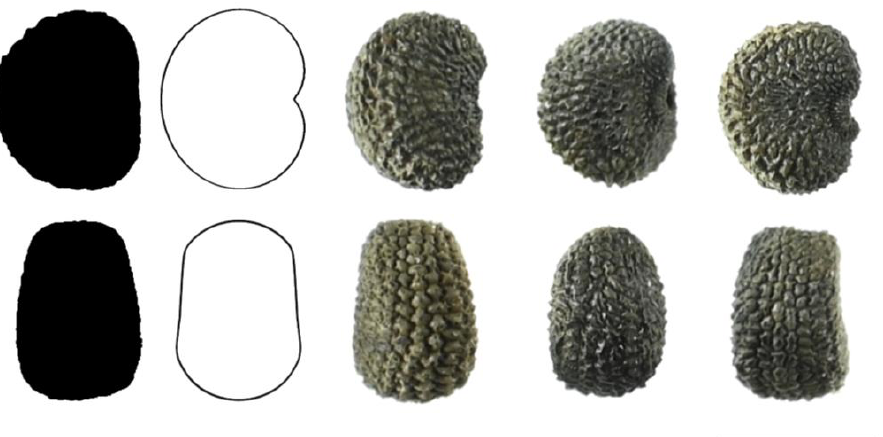
Figure 9. Silene hookeri : average silhouettes (left), the models giving best scores with 20 seeds (LM4 and DM2), and three representative images for the lateral (above) and dorsal (below) seed views. Bar represents 1 mm.